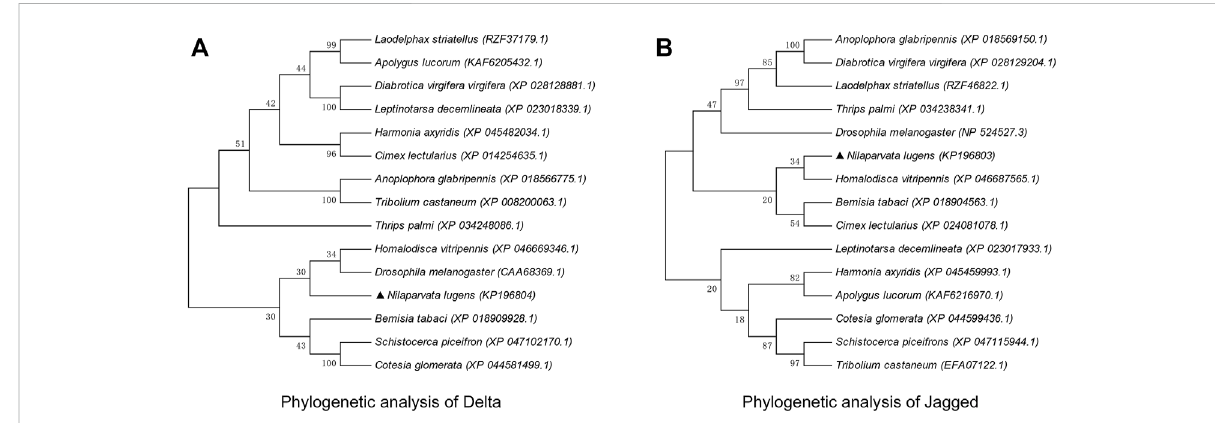
FIGURE 3 Phylogenetic analysis of Delta (A) and Jagged (B) . The phylogenetic tree was constructed through neighbor-joining using MEGA11.0 software. The percentage of replicate trees in which the associated taxa clustered together in the bootstrap test (1,000 replicates) is shown above the branches. Amino acid sequences of Dl and Jag (and its homologous protein Ser) were retrieved from the NCBI database; the respective GenBank accession numbers are shown in brackets after the Latin species